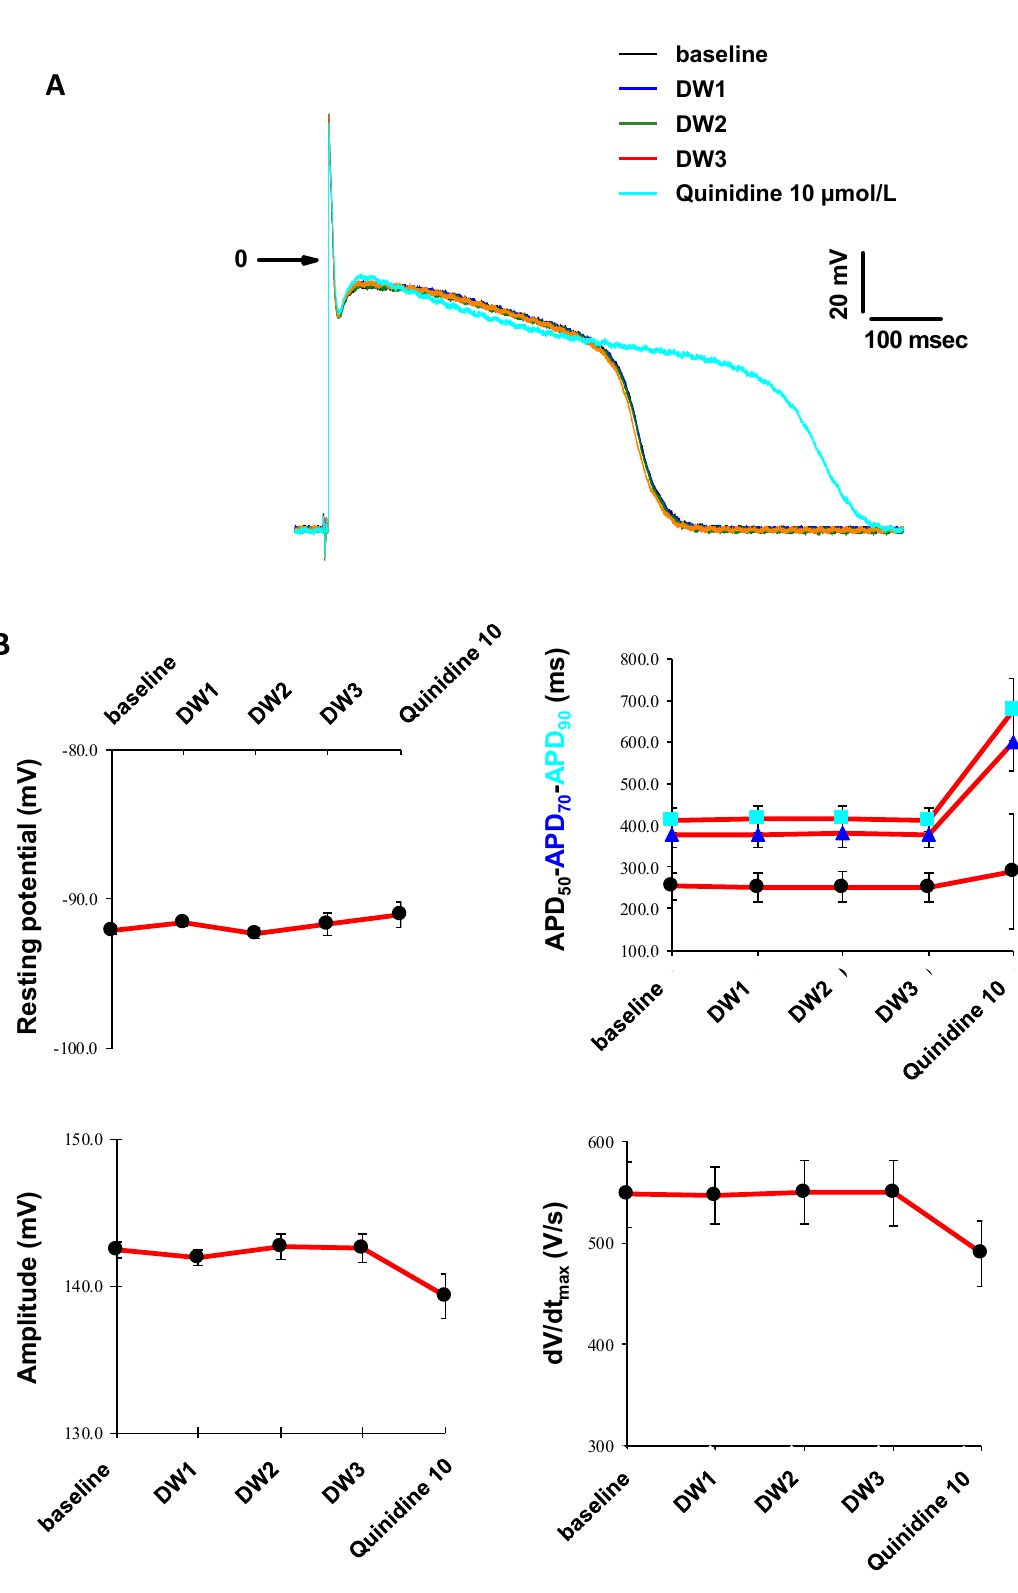
Figure 8. ( A ) Time-dependent effects of distilled water (DW) 0.1% and of Quinidine at 10 µM on the action potential at 1 Hz (one Purkinje fiber representative of three). ( B ) Effects of distilled water (DW) 0.1% and of Quinidine at 10 µM on the four action potential parameters at 1 Hz (Data are expressed as mean ± SEM, n = 3 Purkinje fibers).